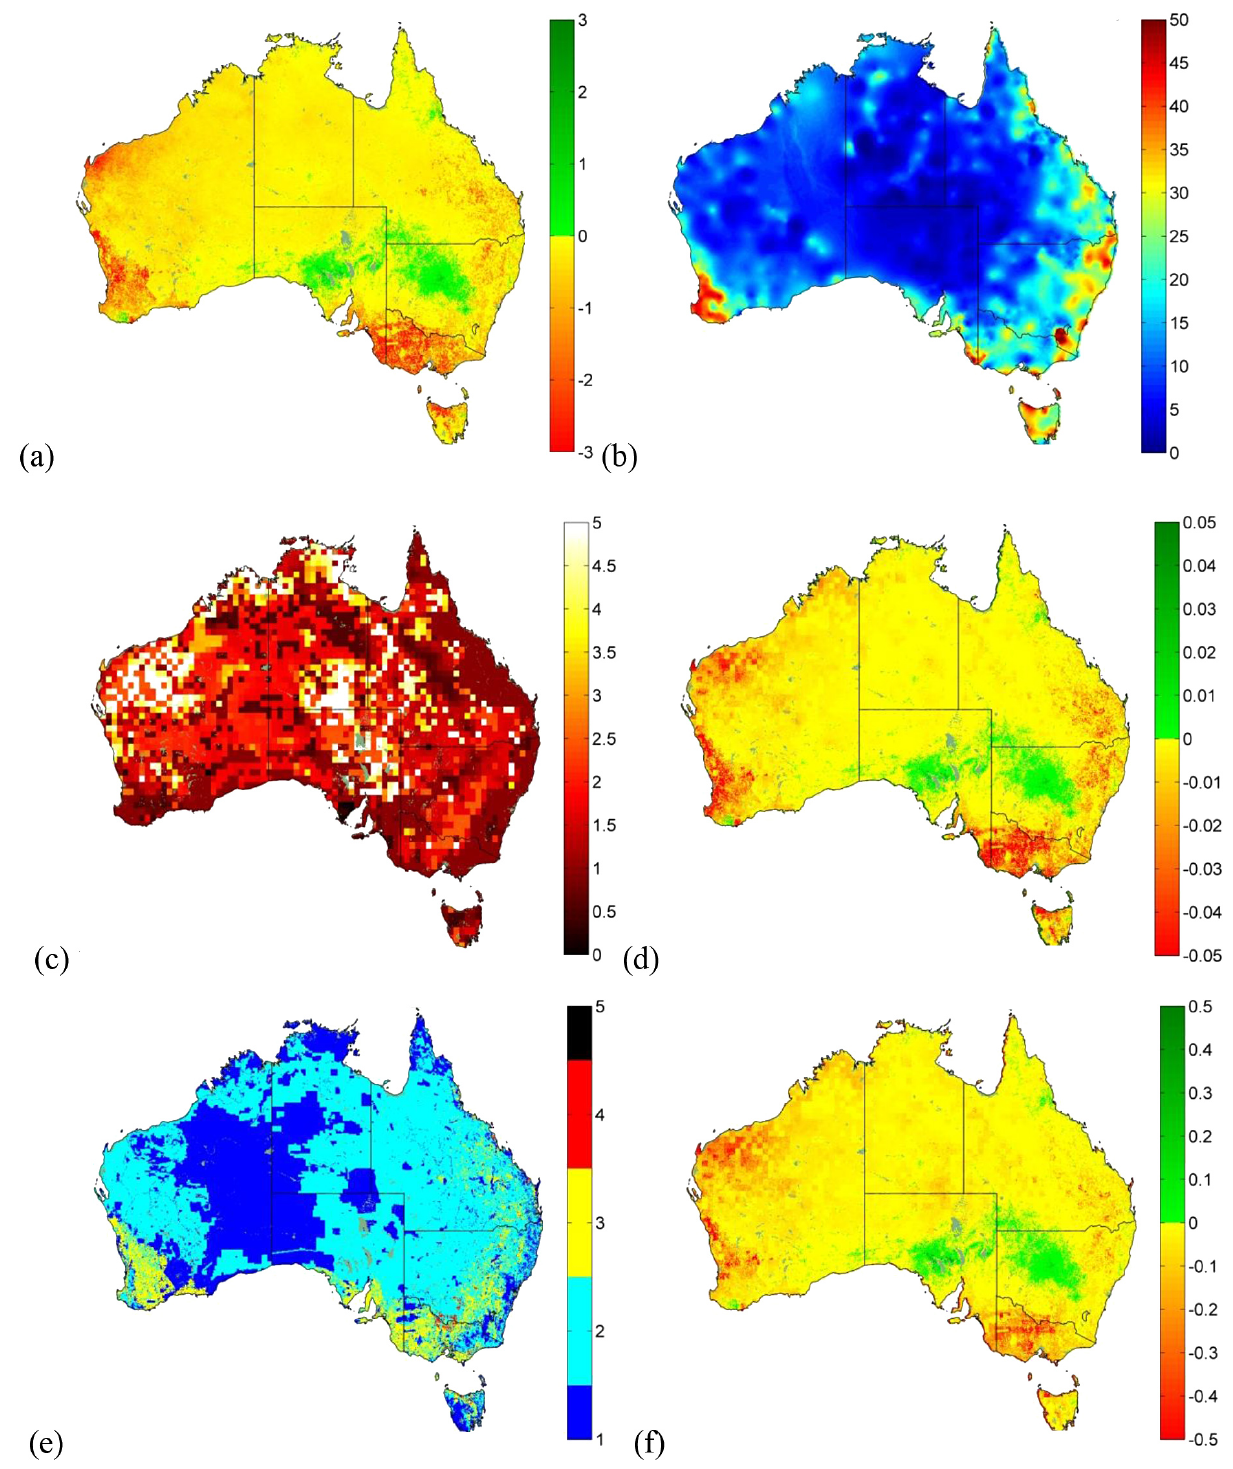
Figure 2. Maps for Australia showing (a) 137 Cs-derived median net (1950s–1990) soil redistribution (t soil ha − 1 yr − 1 ) . Positive values rep- resent sites of net gain, while negative values are those of net loss. (b) Soil organic carbon (SOC) stocks (tC ha − 1 ; 0–10cm). (c) Enrichment ratio at 50km resolution. (d) SOC net redistribution (tCha − 1 yr − 1 ) . (e) Land use (see Table 1). (f) SOC net redistribution as a proportion (%yr − 1 ) of SOC